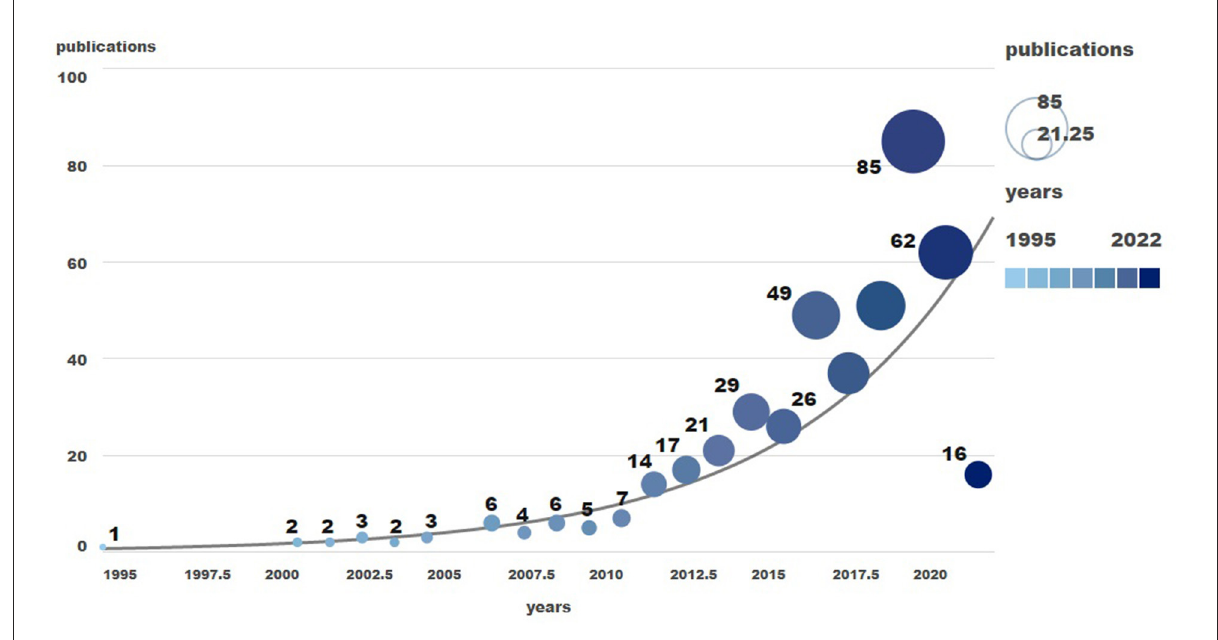
FIGURE1 The annual number of publications related to Al on ASD.